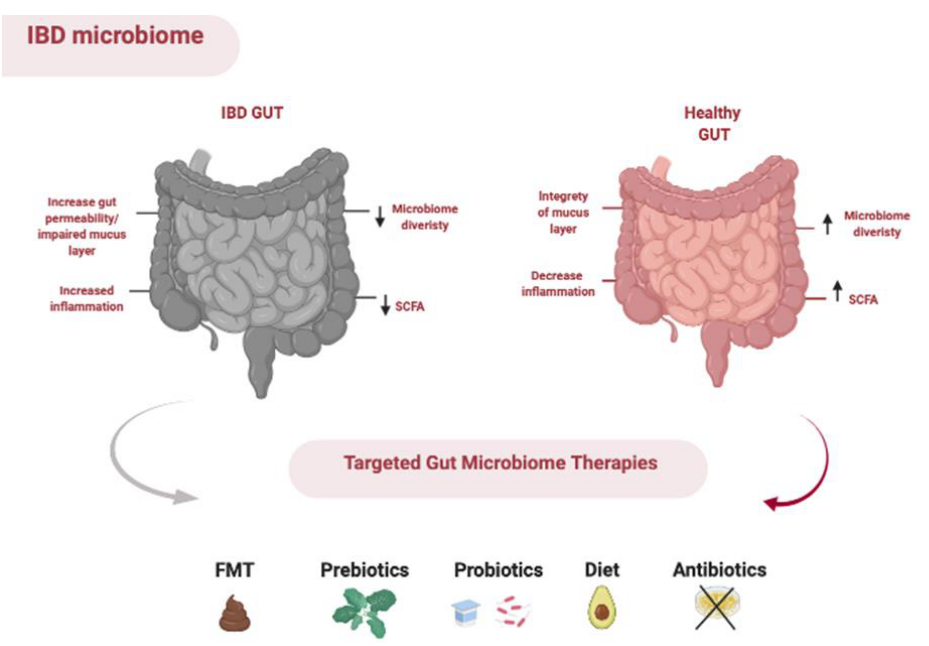
Figure 2. Methods of manipulating the gut